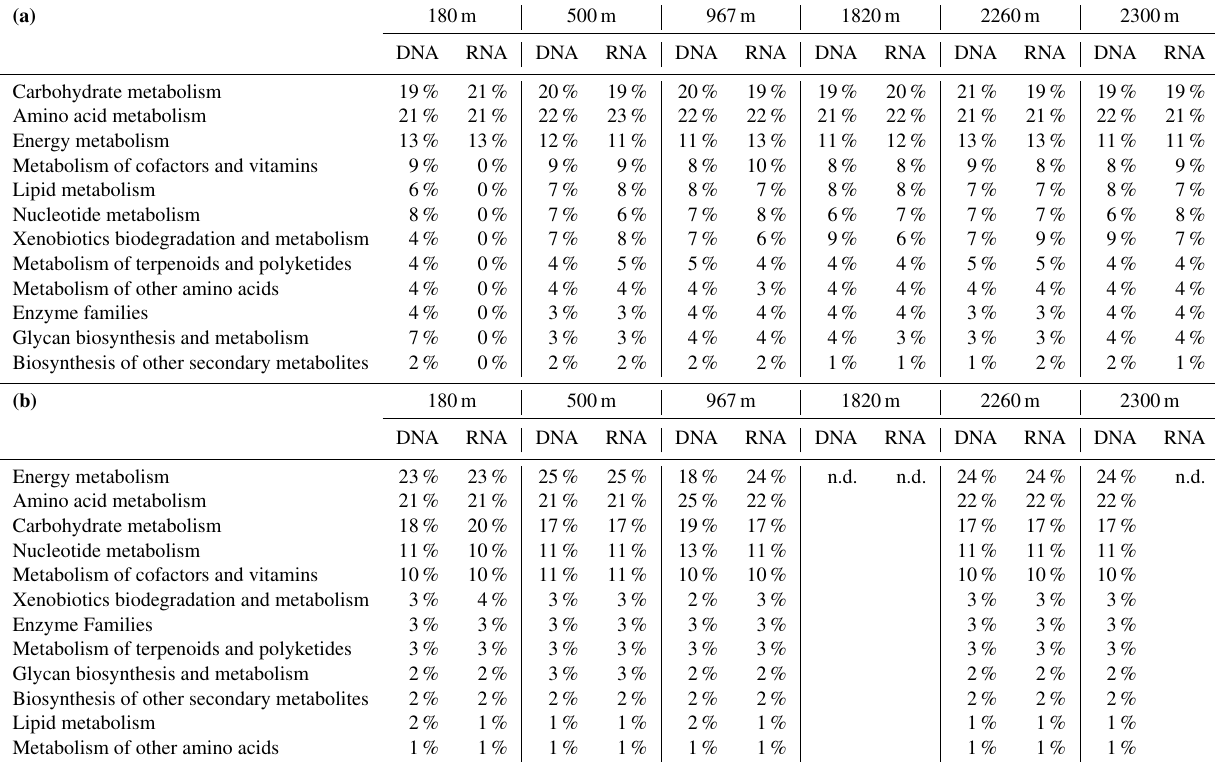
Table 3. The most abundant metabolism-related (a) bacterial and (b) archaeal genes in the predicted metagenomes.